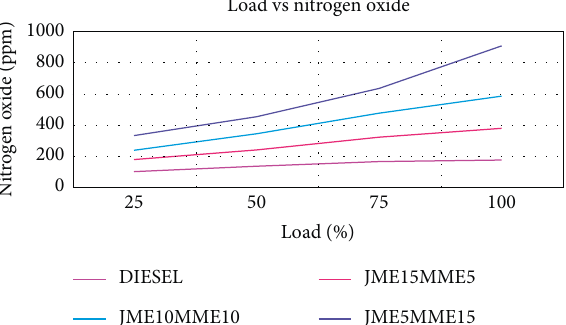
Figure 8: Load vs. CO